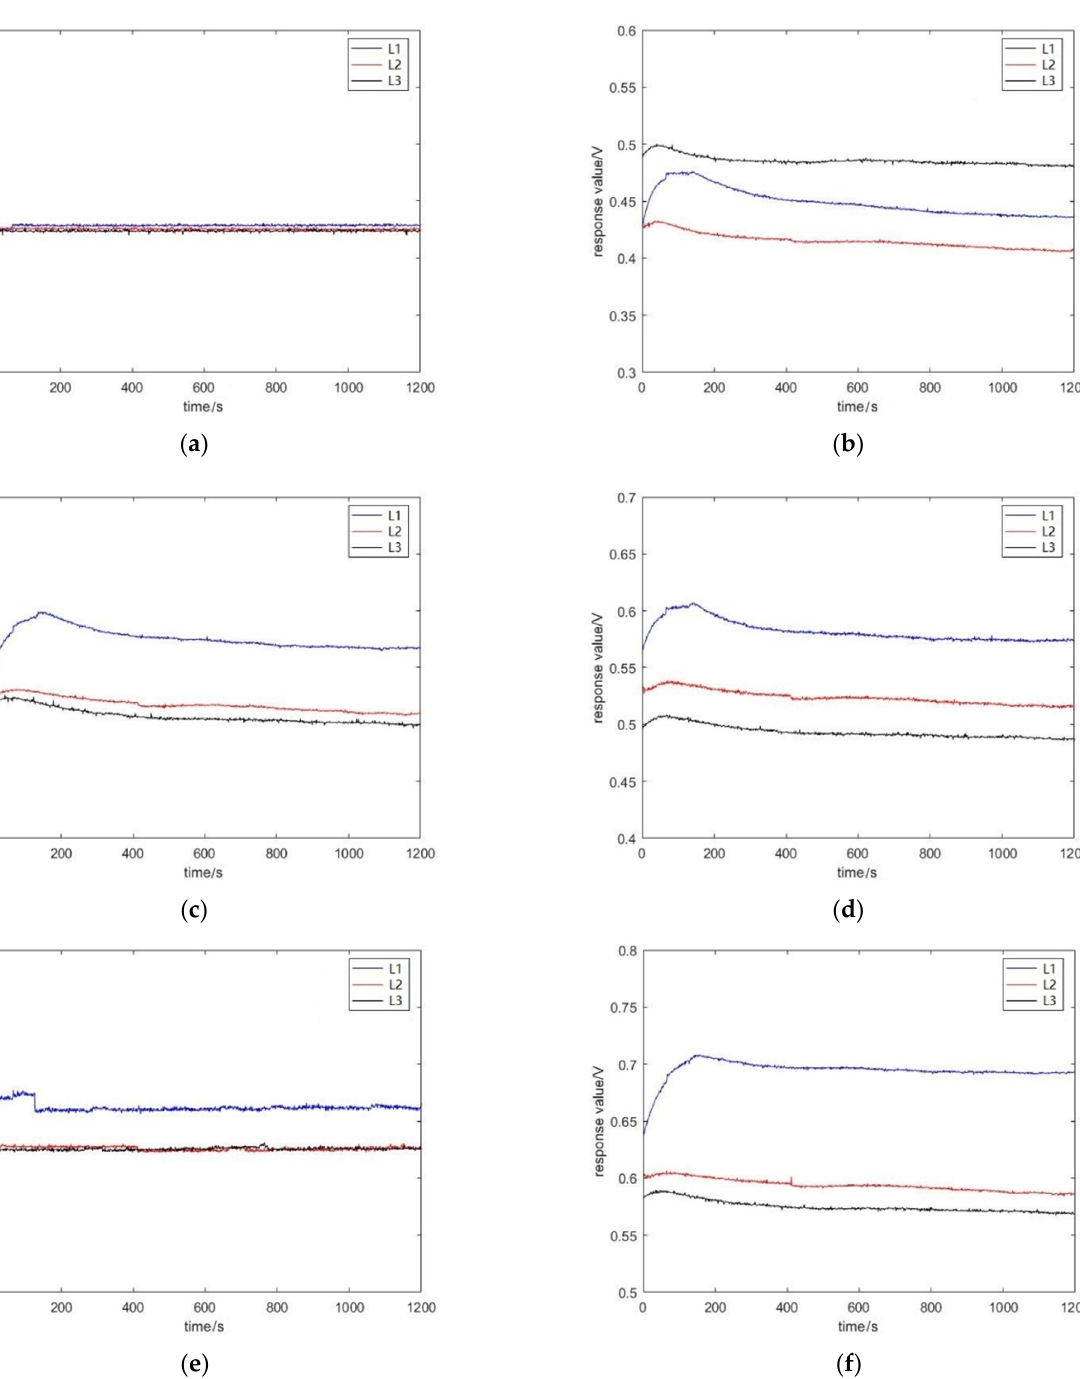
Figure 10. The raw response curves of six sensors for L1, L2, and L3. ( a ) MQ-9, ( b ) MQ-3, ( c ) MQ-6, ( d ) MQ-8, ( e ) MQ-2, ( f ) MQ-135.